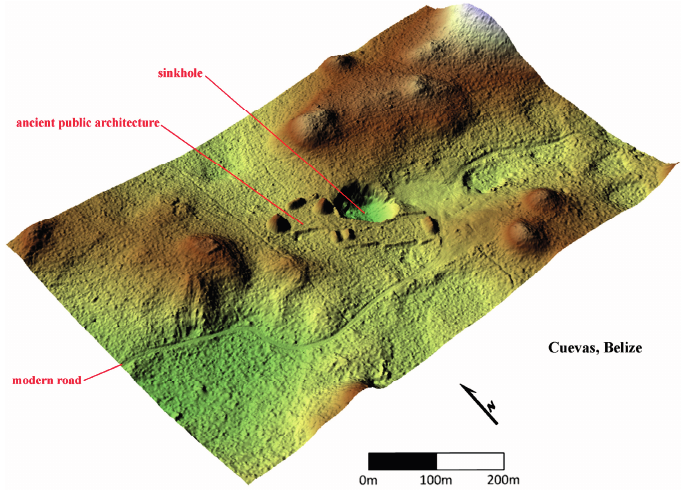
Figure 7. 2.5D LiDAR bare earth rendering of the site of Cuevas, that is located on the edge of a sinkhole leading to an extensive cave